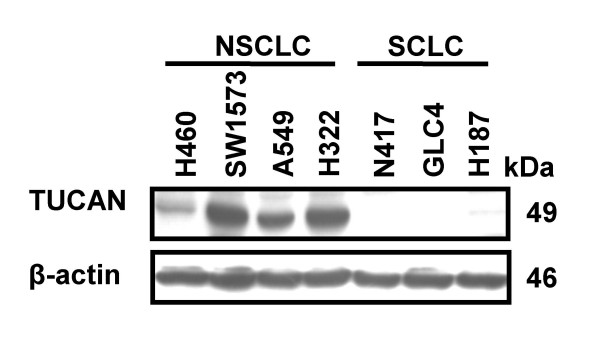
TUCAN expression in a panel of NSCLC and SCLC cells. The expression of TUCAN was determined in the indicated panel of cells by Western blotting. β-actin was used as control for protein loading.